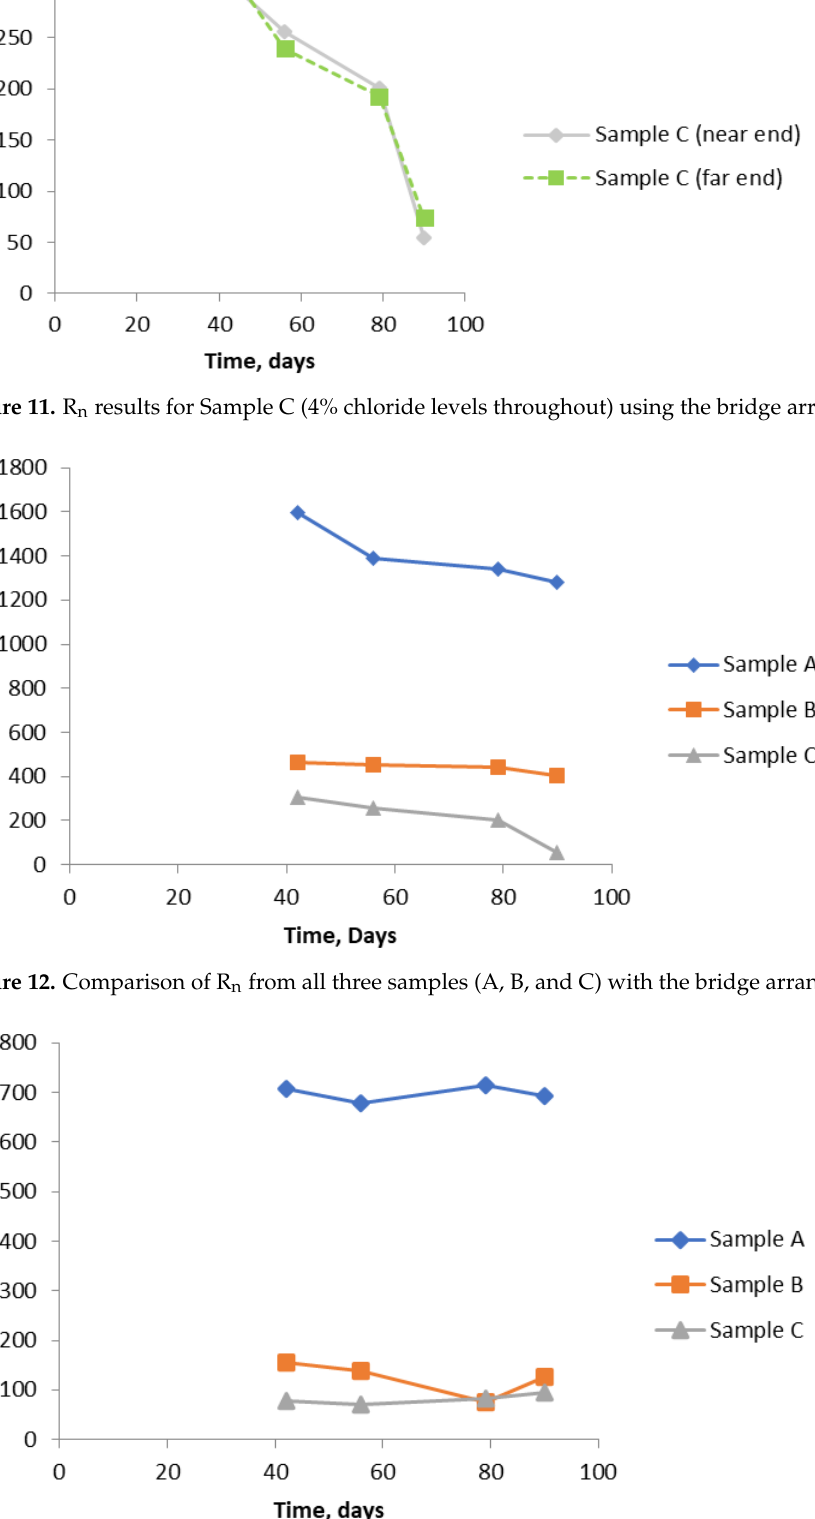
Figure 13. R n results from all three samples (A, B, and C) using the SSS arrangement. Table 2. Average Rn value over whole test period (ohms).